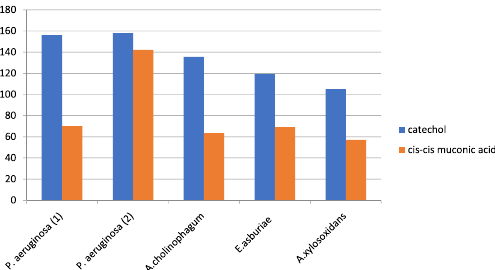
Fig. 3. Formation of different metabolites as byproducts of aniline degradation by the five aniline degrading isolates.